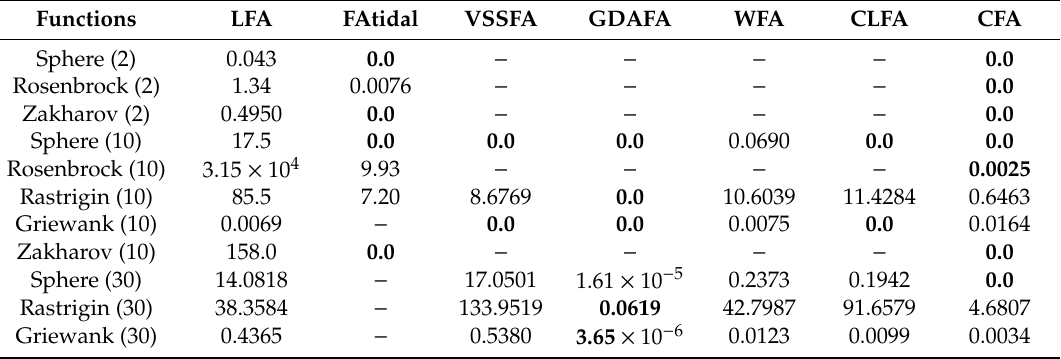
Table 9. The performance comparison between the CFA and the state-of-the-art variants of